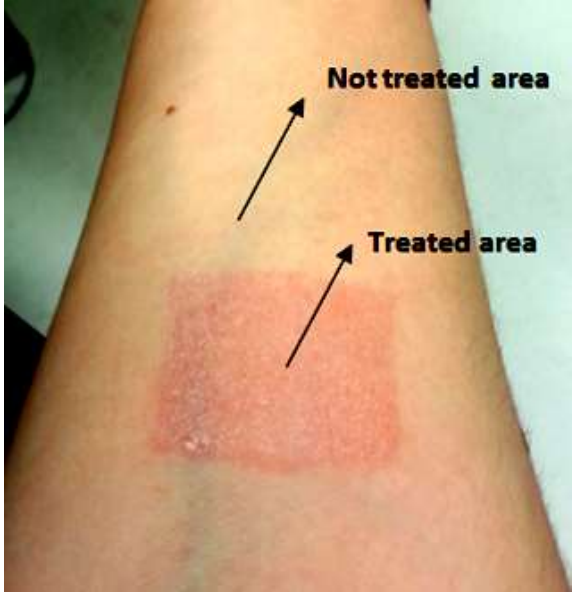
Figure 17. Effect of the camphor-based cream: the red region shows where the cream has been applied.